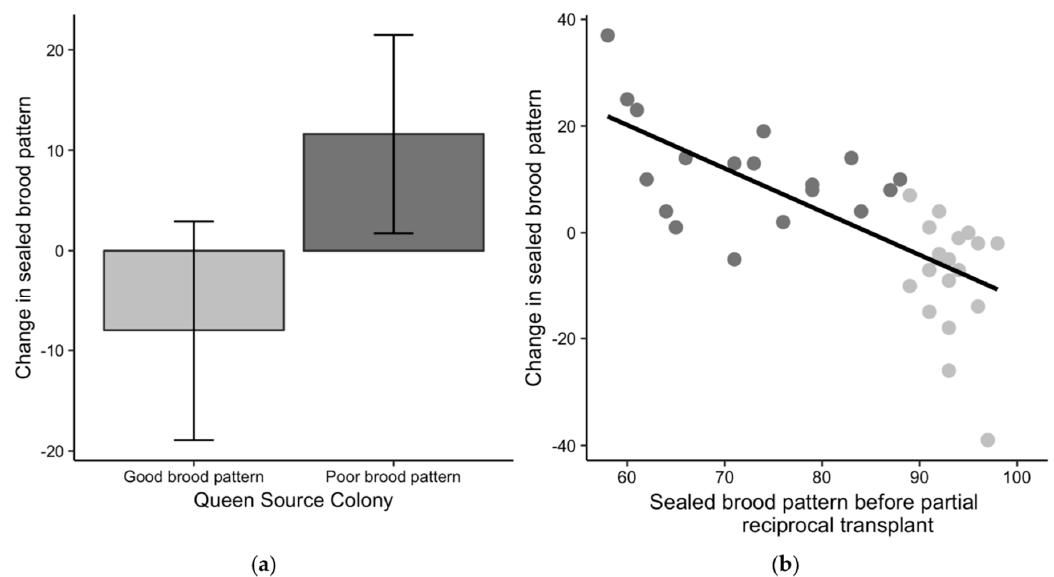
Figure 4. Changes in sealed brood pattern for the partial reciprocal transplant experiment in 2017. ( a ) Comparison of the change in the sealed brood pattern—a queen’s percent of sealed brood cells after the exchange minus her percent of sealed brood cells before the exchange—to the initial brood pattern classification of good (light grey) or poor (dark grey). Positive values indicate an improved brood pattern after the exchange and negative values indicate the pattern was worse after the exchange. ( b ) The potential for change in brood pattern based on the variability in the starting brood patterns.